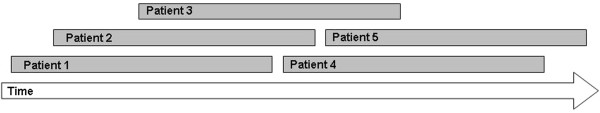
Patient flow in an open group therapy.